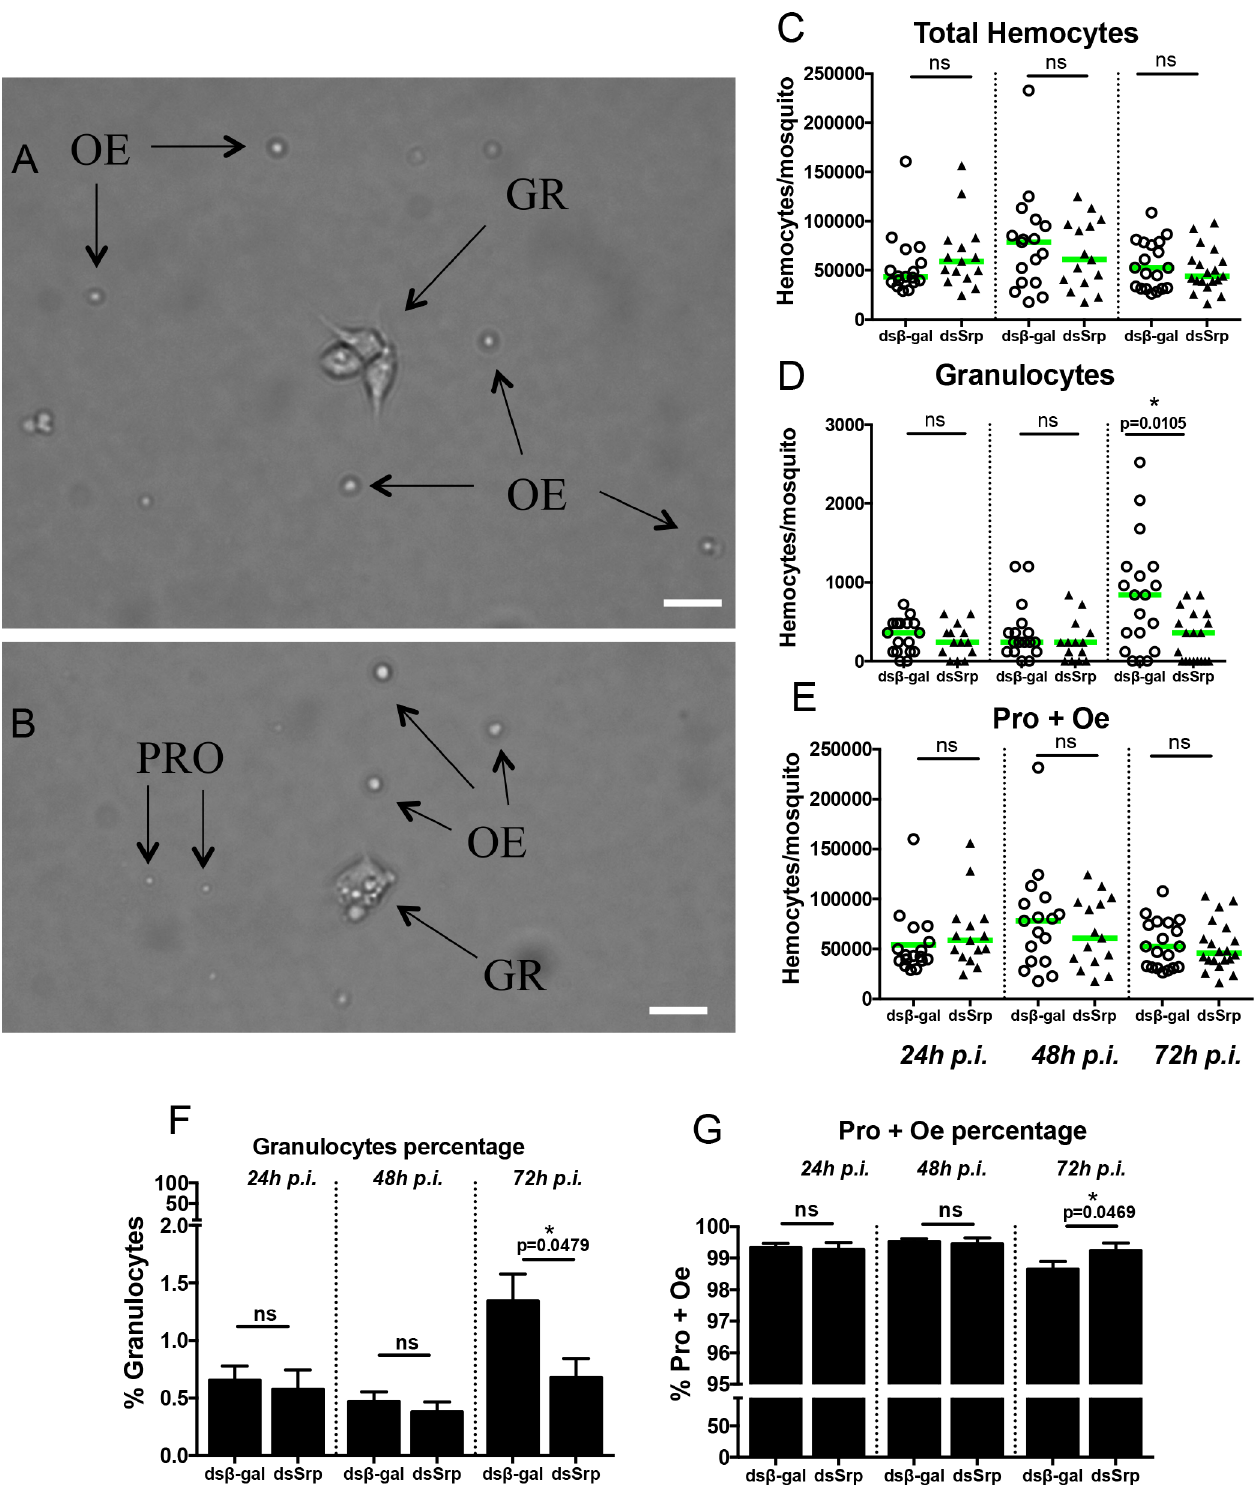
Fig 6. Effect of A . aquasalis GATA-Serpent gene in differentiation of hemocytes. (A-B) representative light microscopy images of hemocyte types from A . aquasalis , prohemocytes (PRO), granulocytes (GR), oenocytoids (OE). (C-E) Number of total hemocytes (C), granulocytes (D), and prohemocytes and oenocytoids (E), and percentage of granulocytes (F) or prohemocytes and oenocytoids (G) obtained from mosquitoes injected with dsSrp or ds β -gal (control) at different timepoints (24, 48 and 72 h) post dsRNA injection (p.i.). Hemocyte numbers are plotted as the median and each individual mosquito is